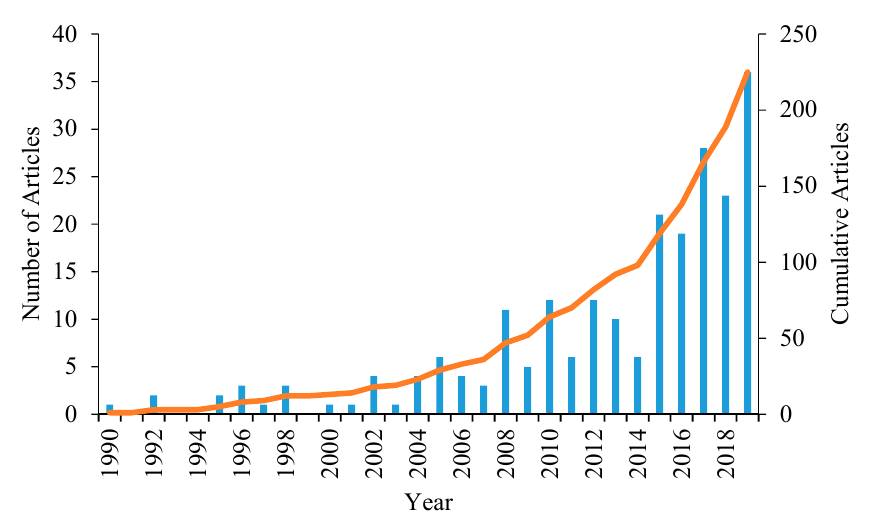
Figure 3. Analysis of the literature database during 1990–October 2019 from Web of Science. The left ordinate axis represents the number of articles per year and the right ordinate axis depicts the cumulative number of articles during the entire analysis period.